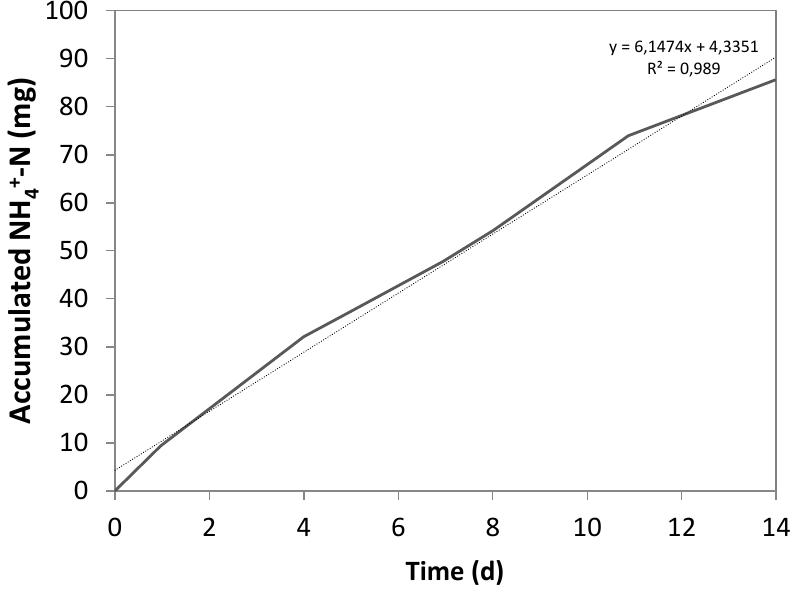
Figure 3. Accumulated NH 4+ -N in the acidic solution during the ARS-HM operation.